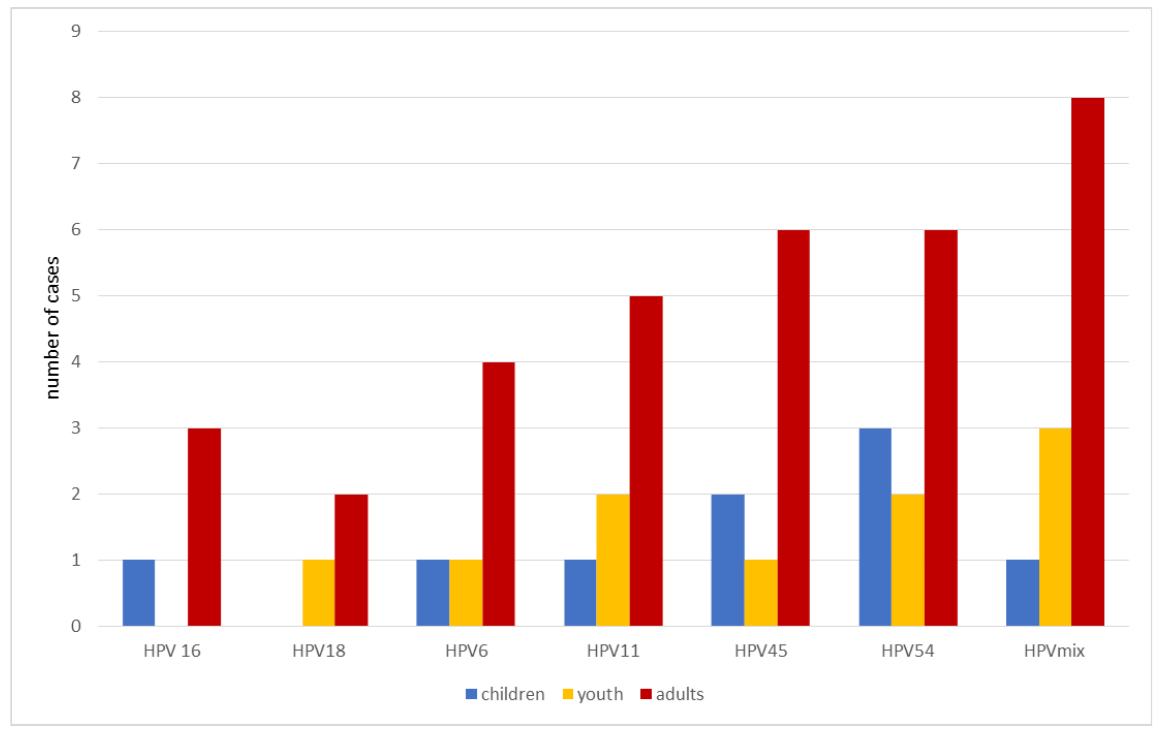
Figure 2. Presence of different HPV genotypes by age groups. HPV mix (HPV 45, HPV 54, HPV 16, HPV 18). An HPV mix can be defined as several genotypes simultaneously. Children (age 5 – 10); youth (age 11 – 19); adults (age 20 – 39; 40 – 59; 60+).